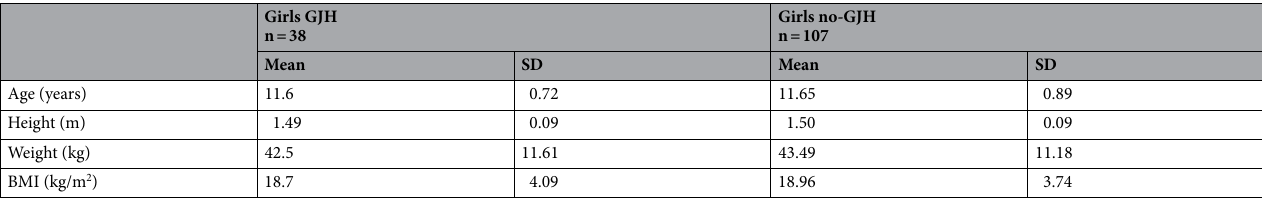
Table 1. Characteristics of girls with (GJH) and without (no-GJH) generalized joint hypermobility (n =